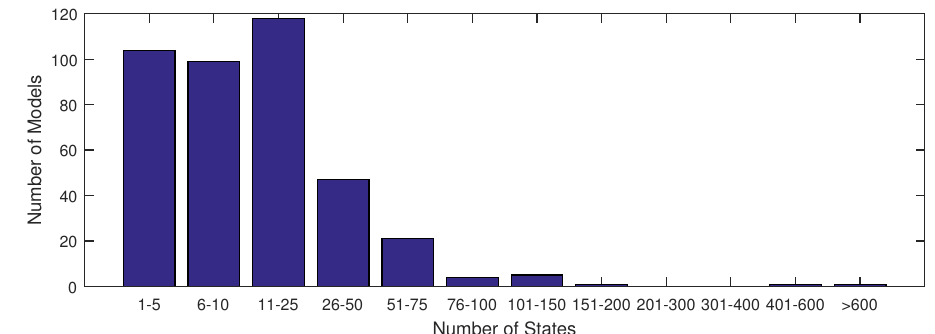
Figure 1. A distribution of model sizes according to number of states from the SBML